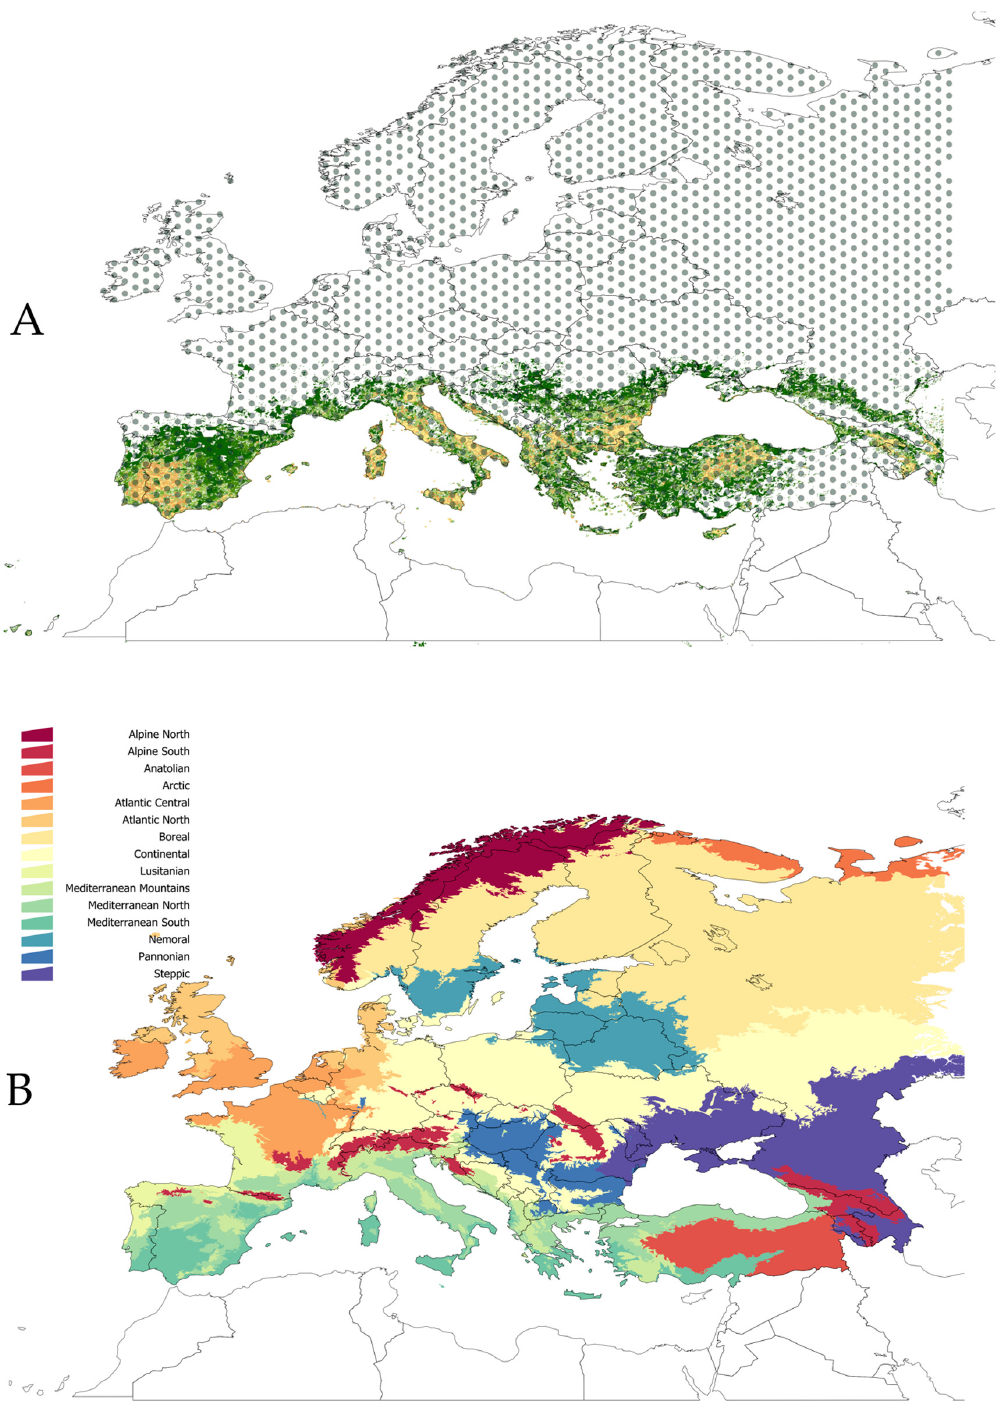
Fig 1. Definitions of the territory covered in this study. (A) The target territory of this study overlaid with the spatial distribution of the points for which weather during the period 1901 – 2009 was used as an input for further modelling analyses. Historically, H . marginatum has been collected in the coloured territory. (B) The division of the territory into climate domains as obtained from the LANMAP framework. The study is restricted to Europe. Therefore the recorded distribution of the tick in northern Africa has been disregarded.